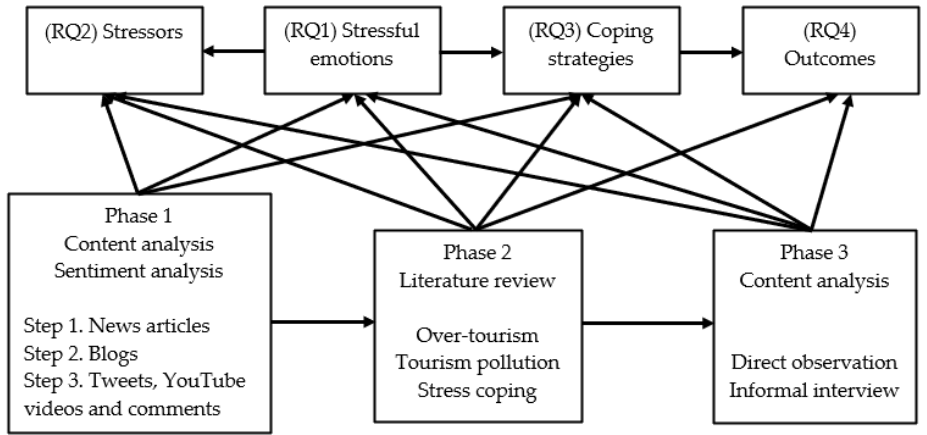
Figure 1. Research process and materials.